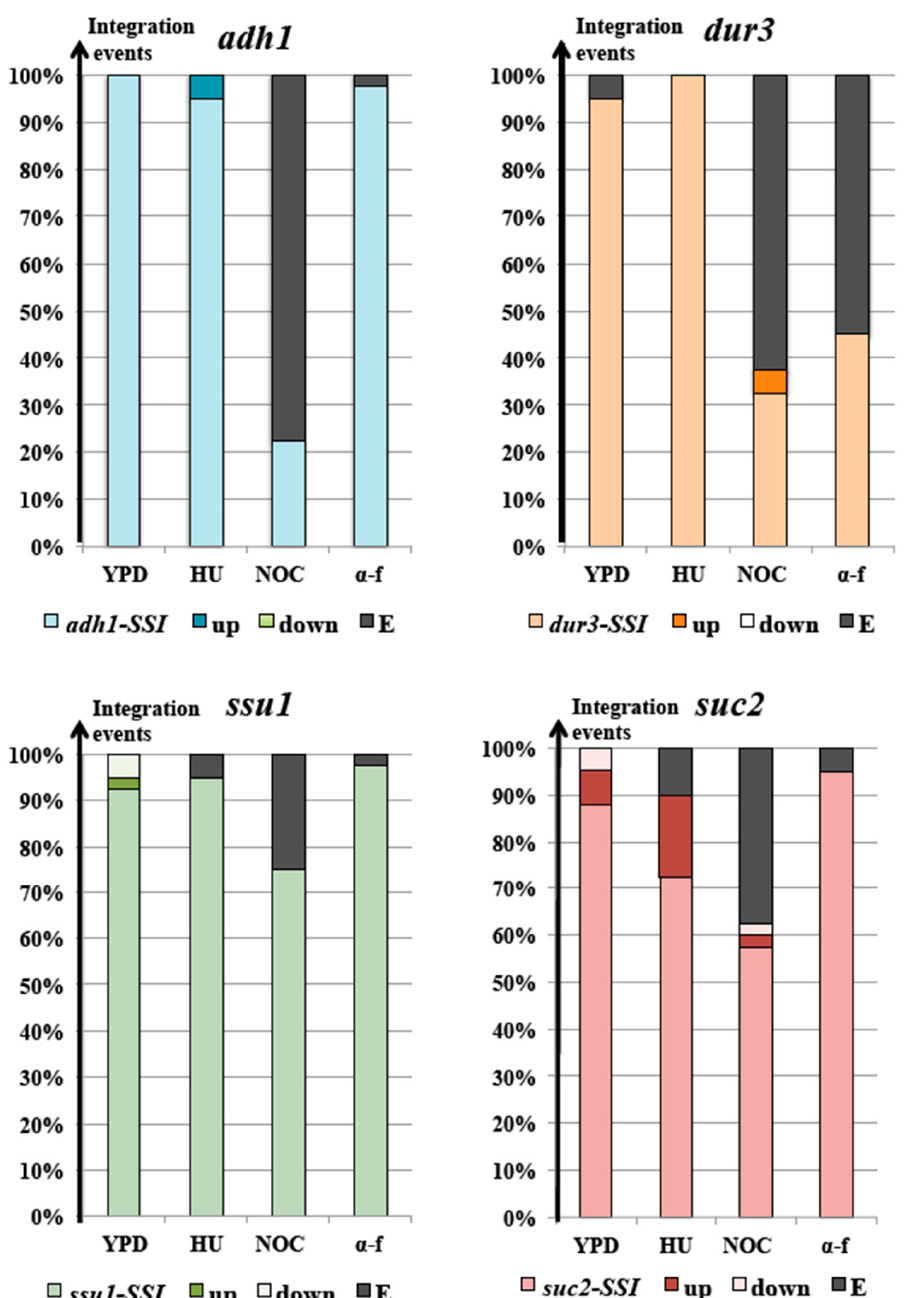
Figure 5. Percentage of integration events obtained using the SSI cassettes. For each locus the percentage of the integration events obtained in an asynchronous cell population grown in YPD (indicated as YPD) and in yeast cells synchronized with HU, NOC or α -f is reported. For each SSI DNA cassette ( adh1 , dur3 , ssu1 , suc2 ) each plot shows (i) the percentage of complete SSI events (indicated as locus-SSI) when both, upstream and downstream ends, were correctly integrated; (ii) one-end-only integration events (upstream indicated as up or downstream indicated as down); and (iii) ectopic events (indicated as E when the cassette integrated into a different site), with respect to the total number of events (100%).